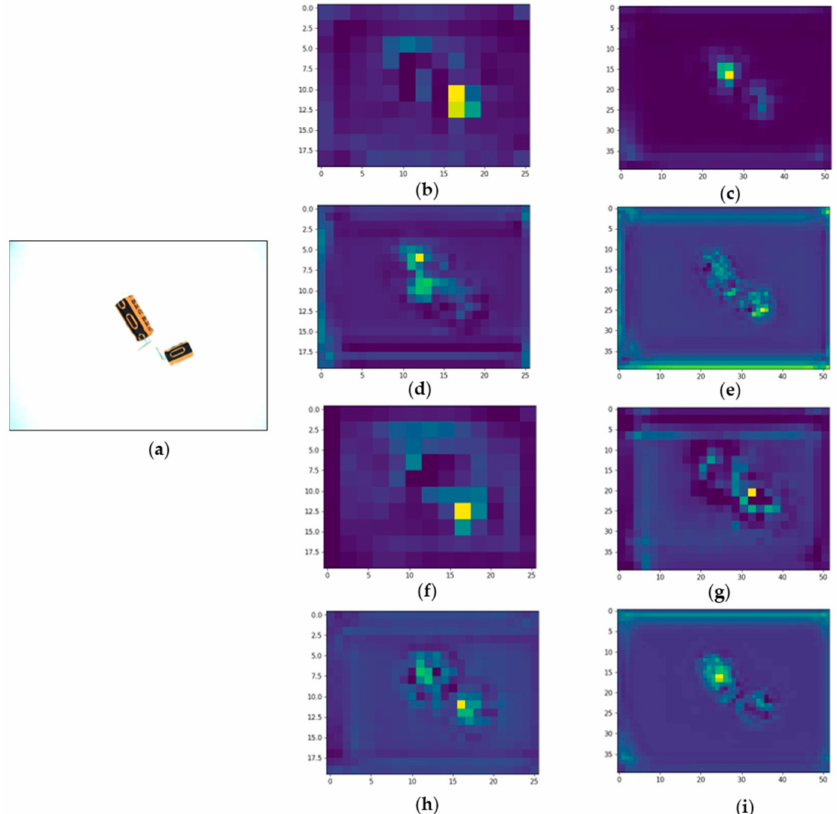
Figure 9. Concatenation and addition feature fusion effect diagram based on YOLOv3 ( a ) Input Picture. ( b ) YOLOv3 first-level concatenation output feature map (YOLOv3:26 × 26 × 512 C (cid:13) 26 × 26 × 256 = 26 × 26 × 768). ( c ) YOLOv3 second-level concatenation output feature map (YOLOv3:52 × 52 × 256 C (cid:13) 52 × 52 × 128 = 52 × 52 × 384). ( d ) YOLOv3-add first-level